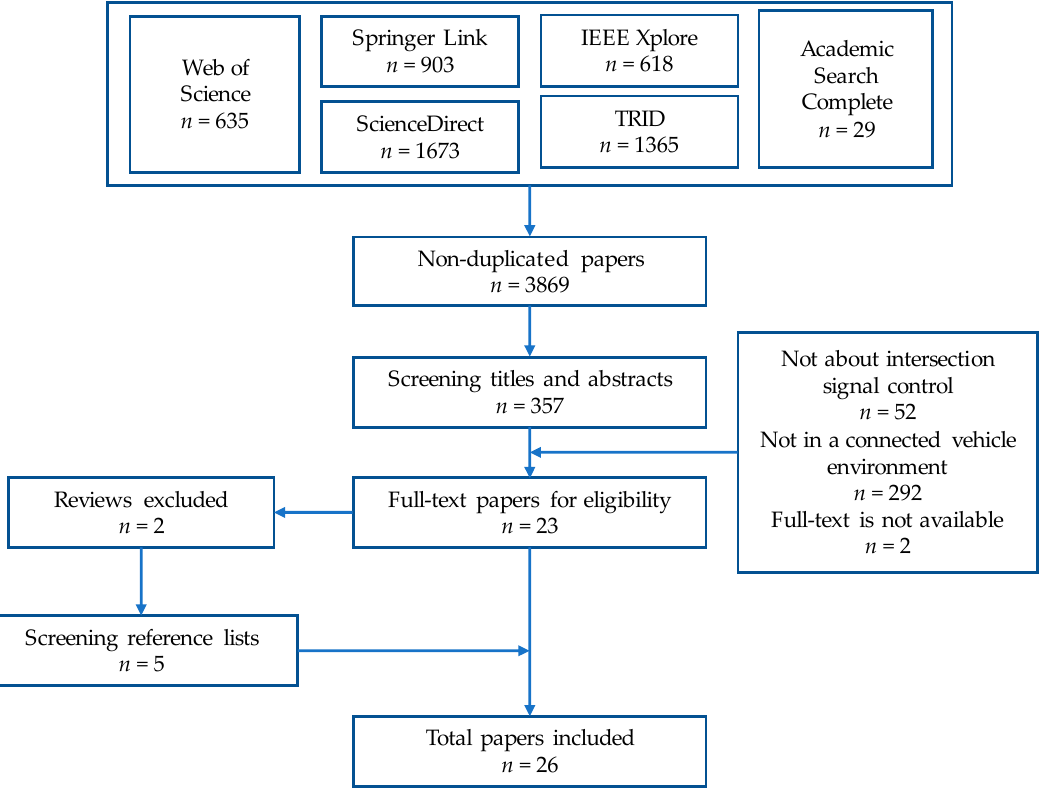
Figure 1. The flowchart of systematic review process.